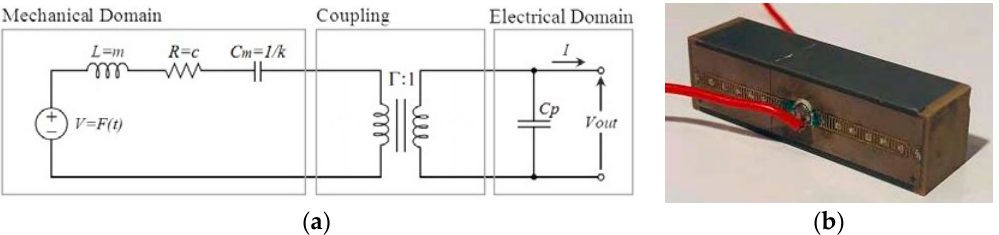
Figure 1. ( a ) The lumped element model of the piezoelectric stack, consisting of mechanical domain, electrical domain and a coupling term, modelled by an ideal transformer. The coupling ratio Γ is described in terms of the material and physical properties of the device, so as to be valid for a piezoelectric stack of arbitrary parameters; ( b ) A multi-layered piezoelectric stack subjected to